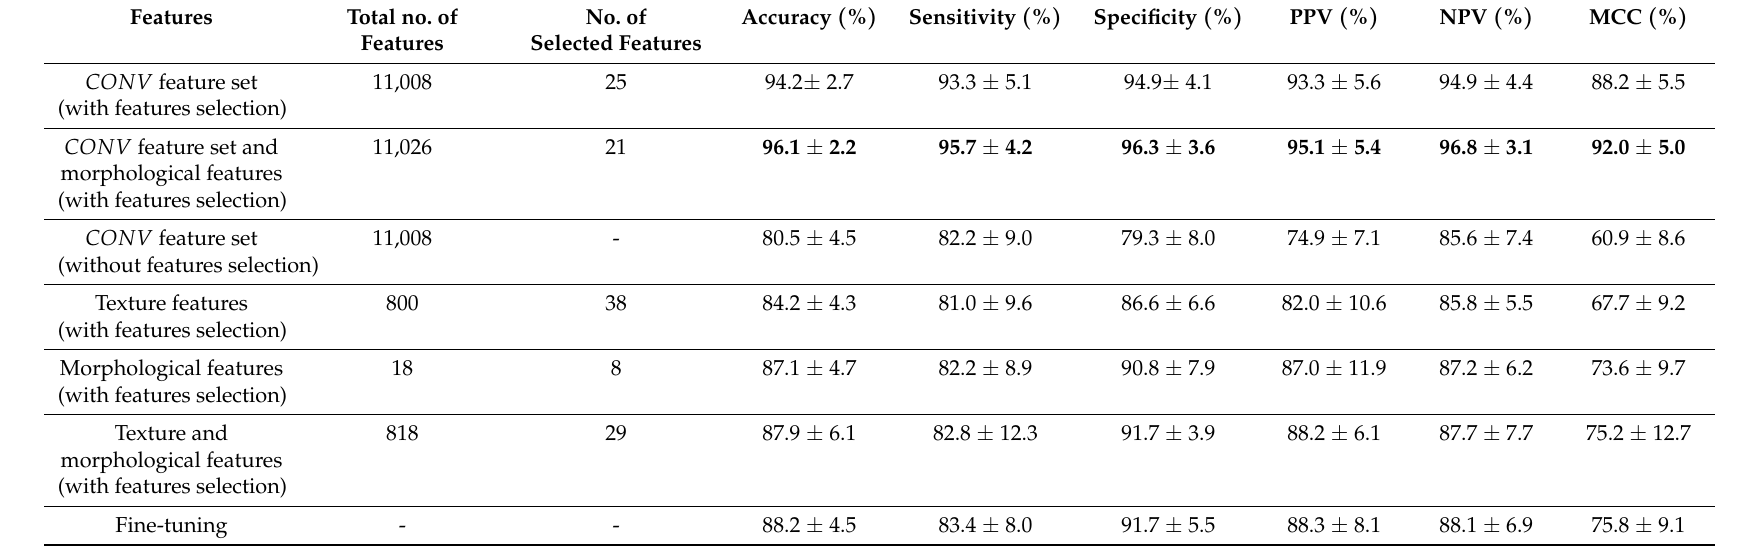
Table 5. Performance comparison between the classification results obtained using the CONV feature set with and without features selection, the combined CONV feature set and morphological features with features selection, the handcrafted texture, morphological, and combined texture and morphological features with features selection, and the fine-tuned VGG19 model. For the six performance metrics, the mean ± standard deviation values are computed across the ten folds of the cross-validation procedure performed using Dataset